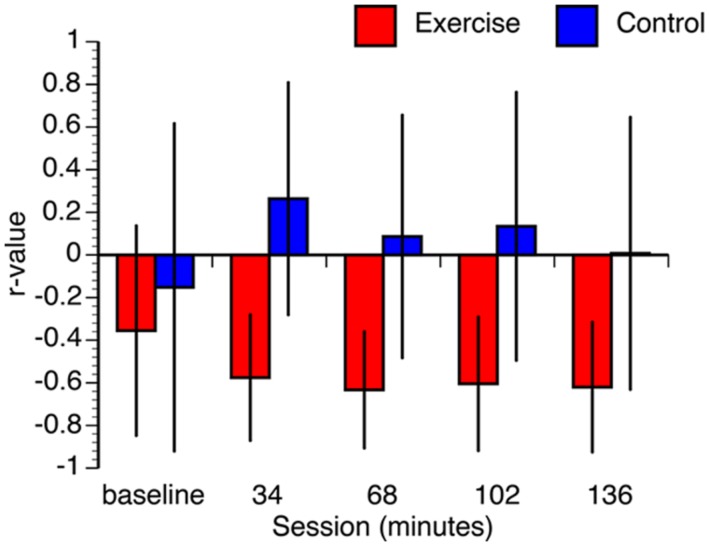
Bootstrap estimated mean correlation values. Error bars represent 95% false coverage rate (FCR) confidence intervals that complement the p < 0.05 FDR-corrected hypothesis tests.